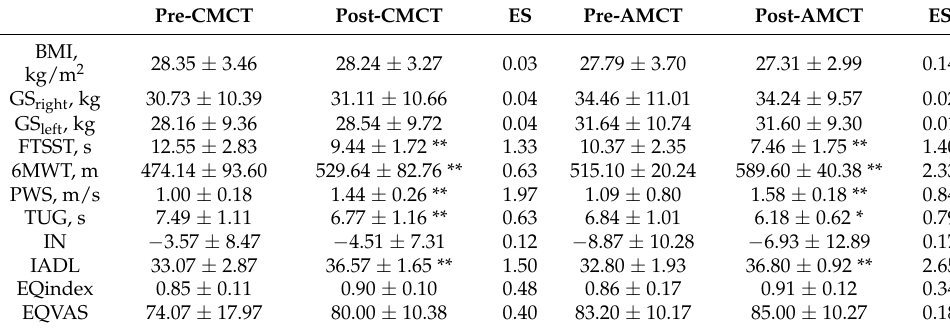
Table 3. Measures for continuous (n = 14) and accumulated groups (n =